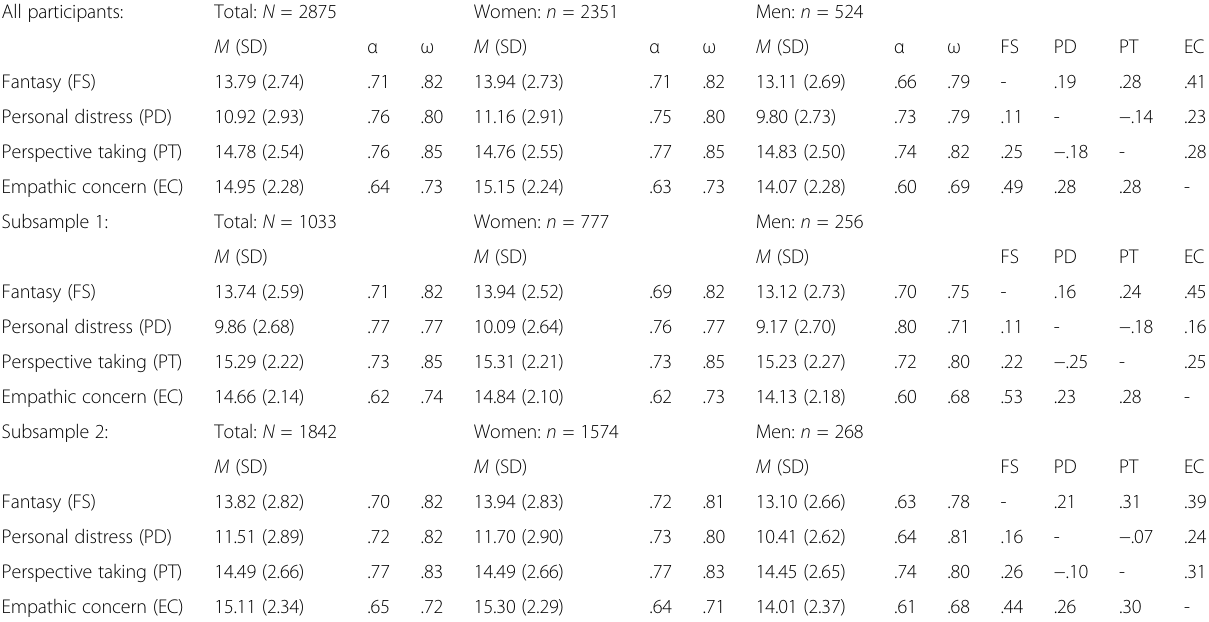
Table 1 Descriptives and correlations between SPF-IRI scales in the full sample and in subsamples. Correlations of scale sum scores above diagonal, correlations of latent variables from ESEM below diagonal All